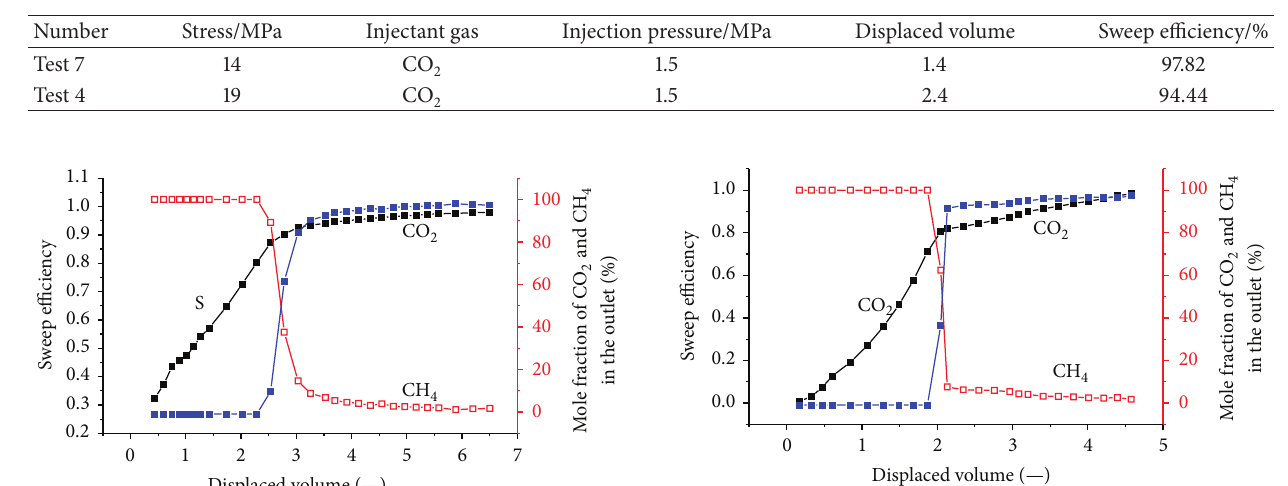
Table 3: Displacement experiment conditions and results under different stress conditions.